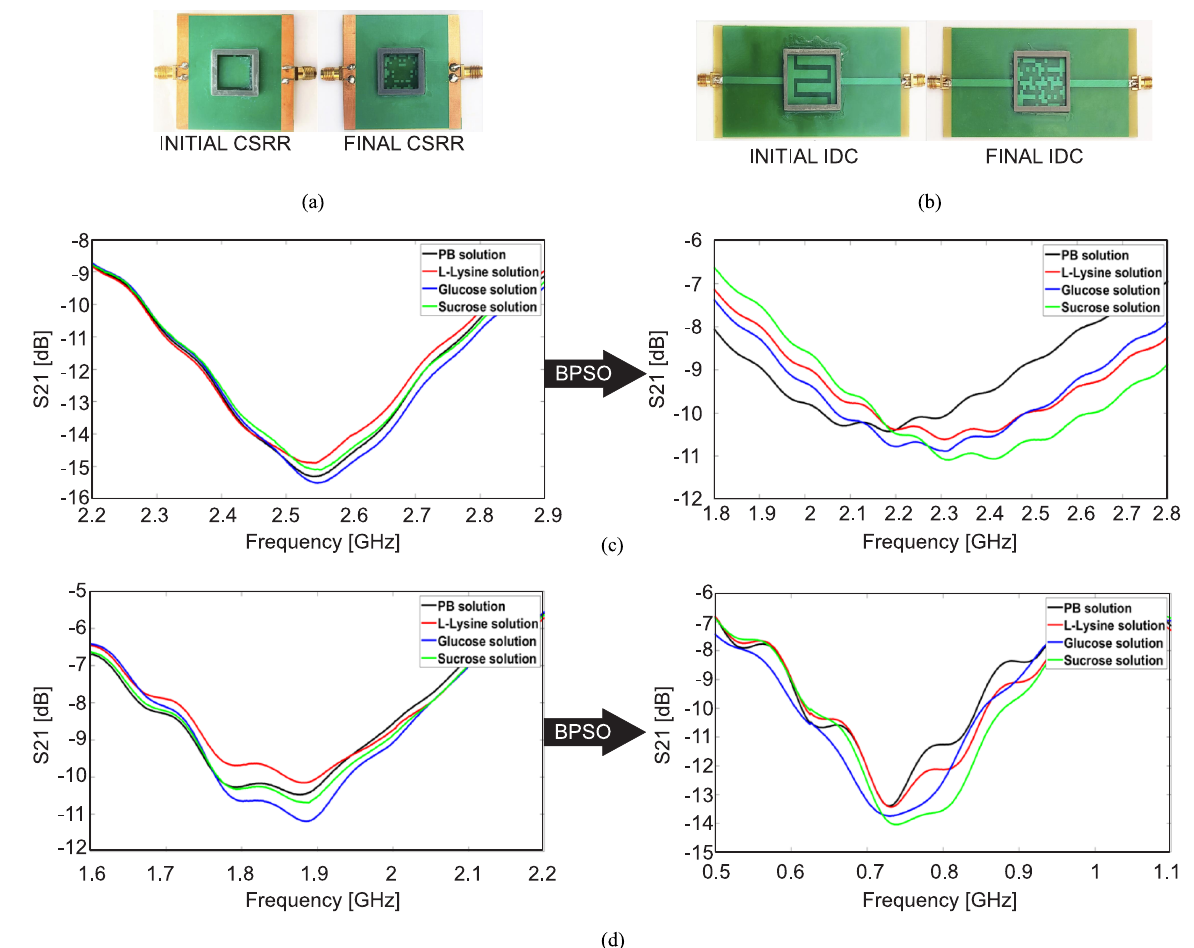
Figure 23. The initial and optimized ( a ) CSRR and ( b ) IDC sensors. The response of the initial and optimized CSRR ( c ) and IDC ( d ) sensors. Reprinted with permission from Ref.